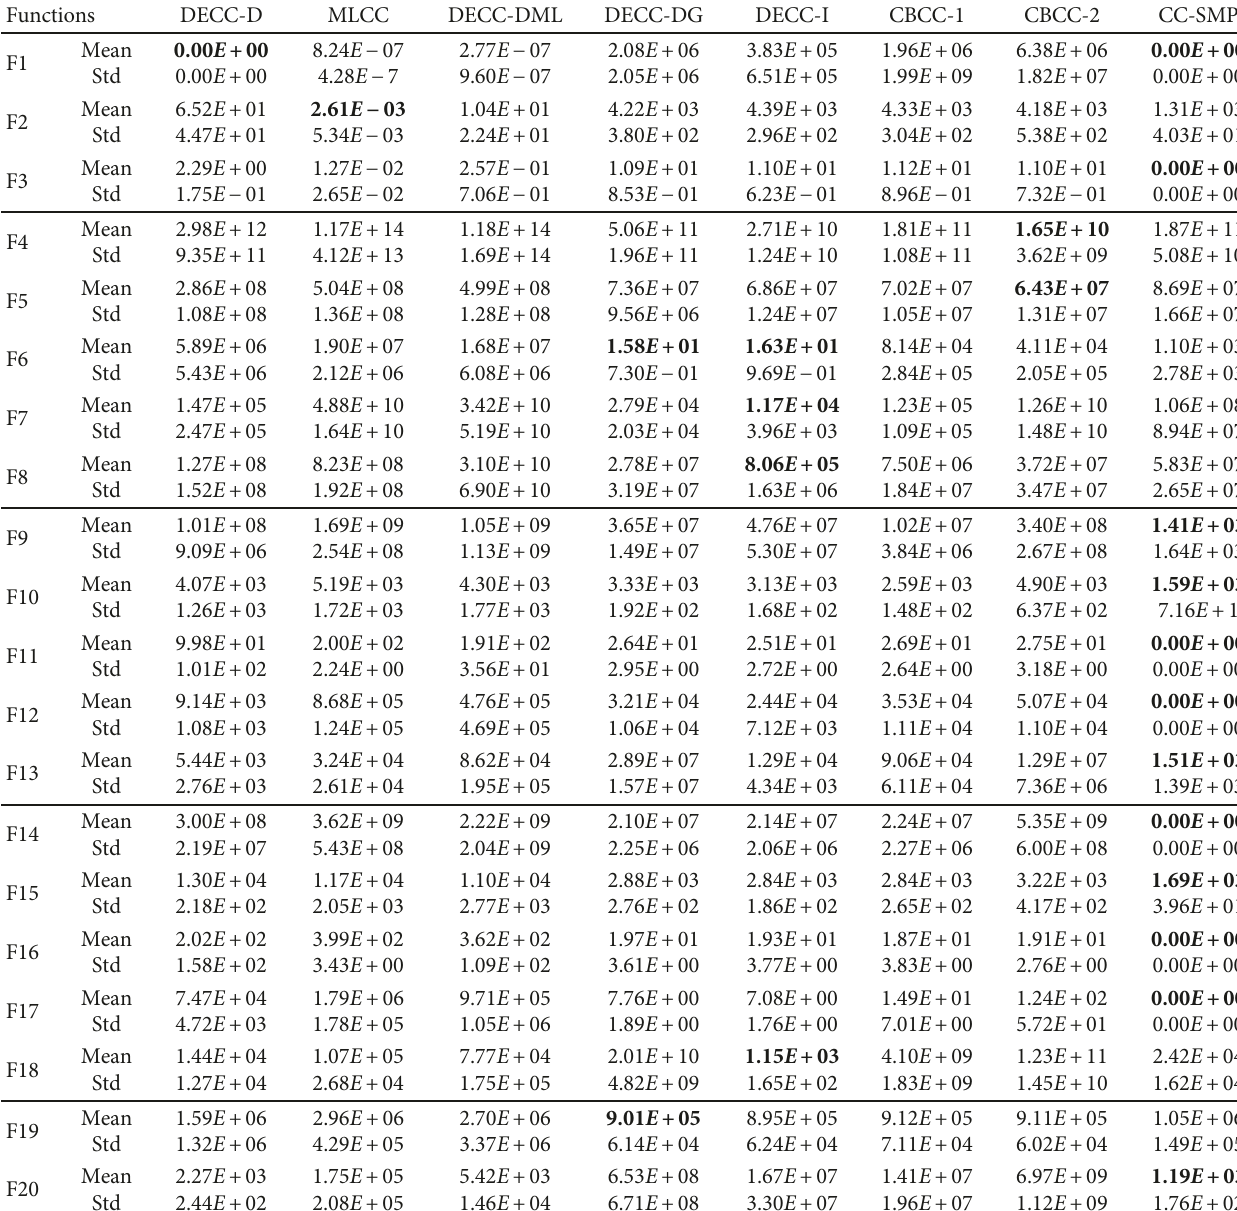
Table 3: Performance comparison on CEC ’ 10 LGSO benchmark functions.